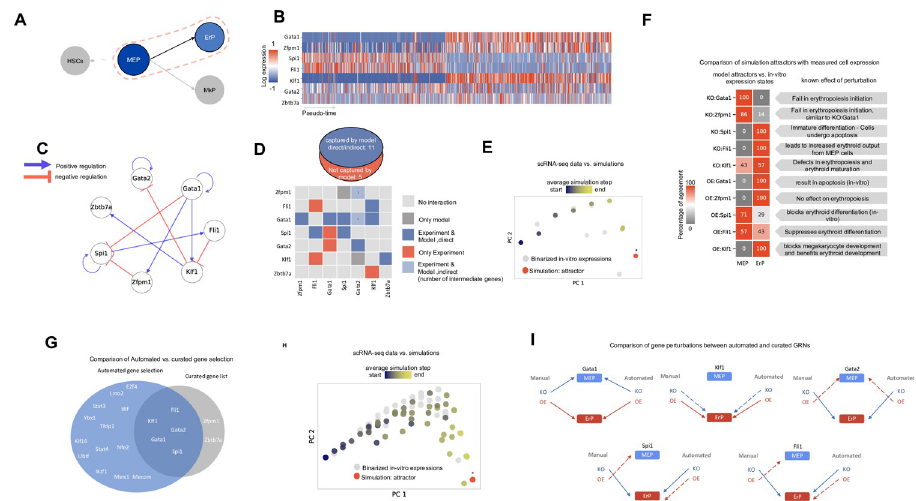
Fig 6. Constructing mouse erythropoiesis GRN. (A) Summary of the scope of the sc-RNA seq data used as an input to IQCELL [17]. Erythroid progenitors (ErP) arise from megakaryocyte/erythroid progenitors (MEPs). (B) Log transformed expression matrix for selected genes from sc-RNA data along the pseudo-time axis. (C) The constructed GRN for mouse erythropoiesis. The GRN is obtained by constraining the possible interactions to both follow the in vitro data progression when executed as a logical network and maximize mutual information between gene pairs. Positive and negative interactions are represented by blue and red edges, respectively. (D) Out of 16 known interactions [15], 11 were captured by IQCELL (top). Detailed representation of the proposed interactions by IQCELL and experimentally reported ones. Rows and columns represent regulators and effector genes, respectively. Blue indicates that the interaction is captured by the model directly (dark blue) or indirectly (light blue); in the latter case, the numbers indicate the number of intermediate genes. Dark gray indicates that the interaction is only proposed by IQCELL. The red color indicates the experimentally validated interaction is not present in the model. Light gray cells indicate no interaction (bottom). (E) The PCA plot of the simulated developmental trajectories are overlaid on the binarized scRNA-seq (the curated genes). The detected attractor is colored red and is marked by star ( � ). The arrow (blue-red) represent the direction of inferred pseudo-time. (F) Percentage of similarity between the model attractors under perturbations (vertical axis) and binarized expression of MEPs and ErPs (horizontal axis) (left). Description of known effect of the gene perturbation (right). (G) Comparison of automated vs curated TF selection show that the TF selection pipeline captures 5 of 7 genes in the curated gene list. (H) The PCA plot of the simulated developmental trajectories are overlaid on the binarized scRNA-seq (the genes resulting from automated TF selection). The detected attractor is colored red and is marked by star ( � ). The arrow (blue-red) represent the direction of inferred pseudo-time. (I) Comparison of gene perturbations between automated and curated GRNs show 8 matches of the predicted states out of 10